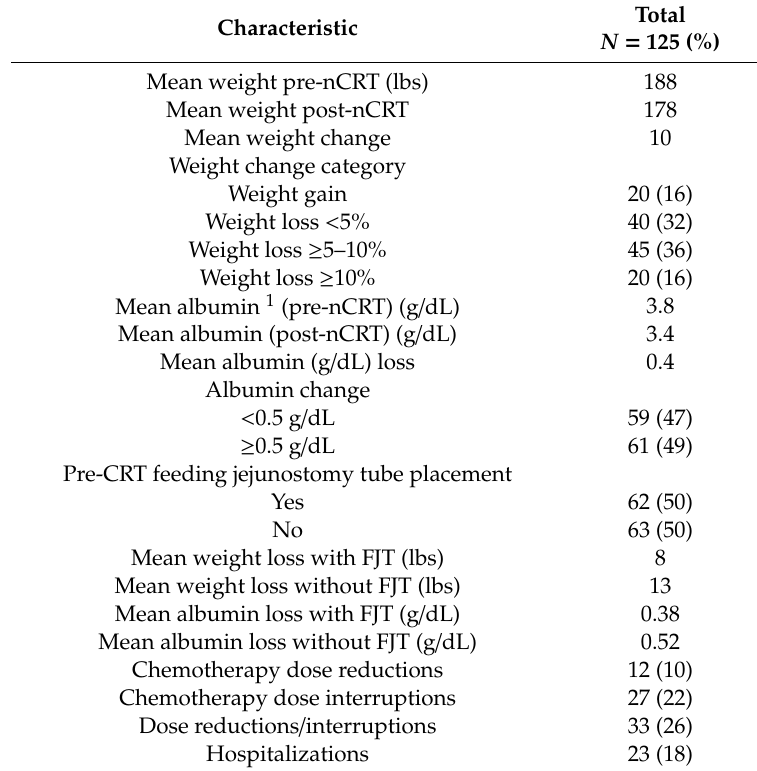
Table 3. Chemotherapy dose reductions were required in 10% of patients while dose interruptions were required in 22%. In total, 26% of patients had dose interruptions or reductions and were unable to receive all planned chemotherapy. Eighteen percent of patients had unplanned hospitalizations during nCRT for management of nCRT-related toxicity. Table 3. Changes in nutritional markers and onset of toxicity during neoadjuvant chemoradiation therapy. Total Characteristic N = 125 (%) Mean weight pre-nCRT (lbs) 188 Mean weight post-nCRT 178 Mean weight change 10 Weight change category Weight gain 20 (16) Weight loss < 5% 40 (32) Weight loss ≥ 5–10% 45 (36) Weight loss ≥ 10% 20 (16) Mean albumin 1 (pre-nCRT) (g / dL) 3.8 Mean albumin (post-nCRT) (g / dL) 3.4 Mean albumin (g / dL) loss 0.4 Albumin change < 0.5 g / dL 59 (47) ≥ 0.5 g / dL 61 (49) Pre-CRT feeding jejunostomy tube placement Yes 62 (50) No 63 (50) Mean weight loss with FJT (lbs) 8 Mean weight loss without FJT (lbs) 13 Mean albumin loss with FJT (g / dL) 0.38 Mean albumin loss without FJT (g / dL) 0.52 Chemotherapy dose reductions 12 (10) Chemotherapy dose interruptions 27 (22) Dose reductions / interruptions 33 (26) Hospitalizations 23